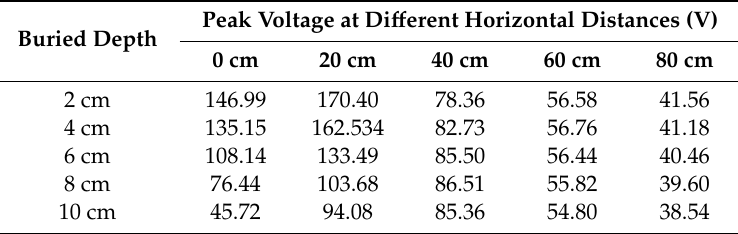
Table 3. Maximum positive voltage of PEH.